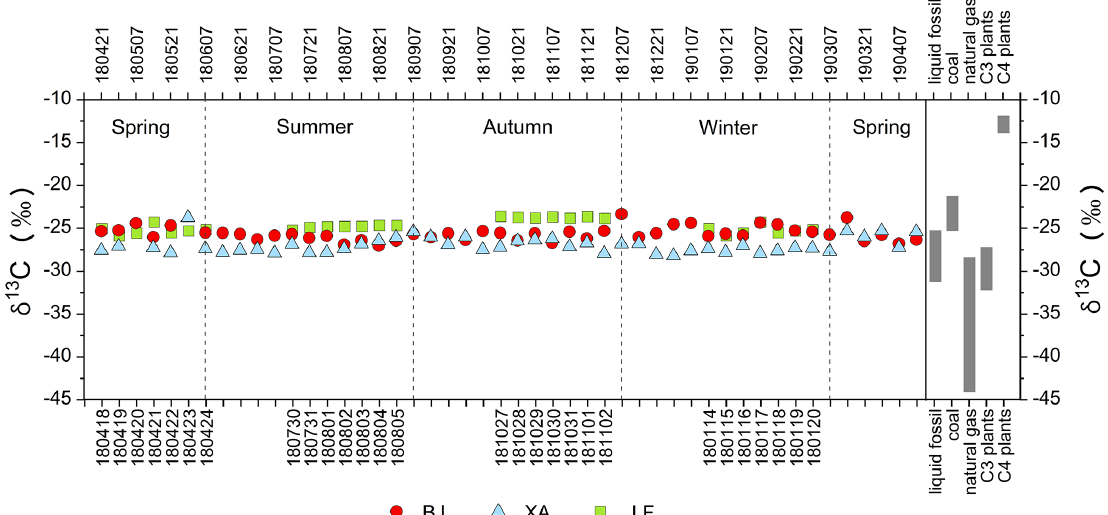
Figure 6. δ 13 C values of samples from BJ, XA, and LF and comparison with the δ 13 C distribution of various sources. The abscissa represents the sampling date (yymmdd). The tick labels of the top axis represent the dates of BJ and XA, and the bottom axis represents the date of LF. The gray box indicates the δ 13 C of the main source (Agnihotri et al., 2011; Huang et al., 2006; López-Veneroni, 2009; Martinelli et al.,